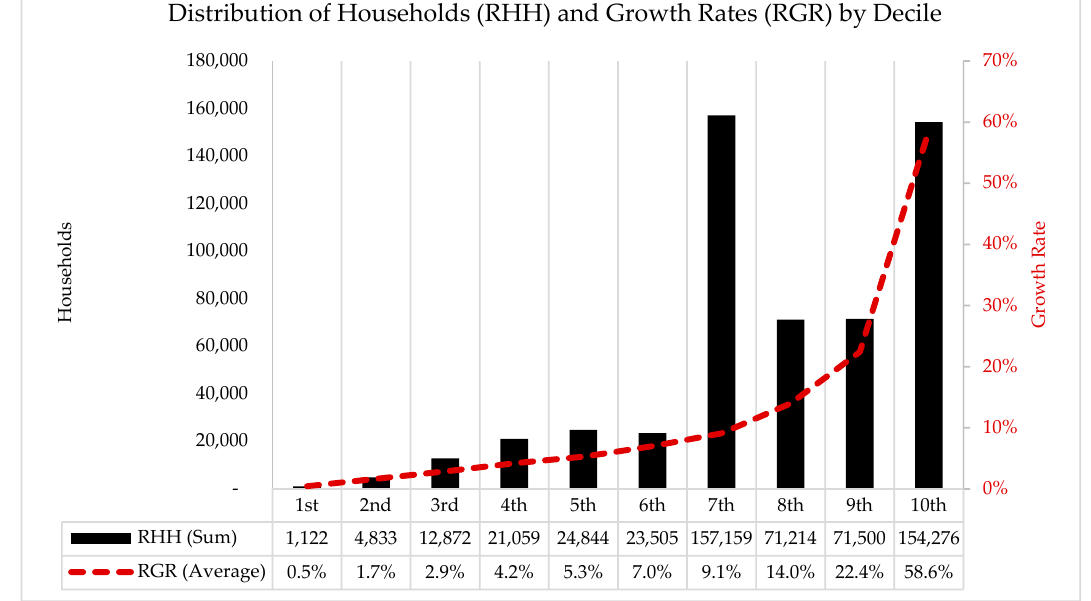
Figure 2. The RHNA Households (RHH) and RHNA Growth Rates (RGR) by Decile. The sample’s 185 cities were ranked by RGR percentile and grouped into deciles according to SCAG’s 4th RHNA Cycle (2006–2014). The first decile was assigned an RHH of 1122 housing units and maintained an average RGR of 0.5%. Source. SCAG.